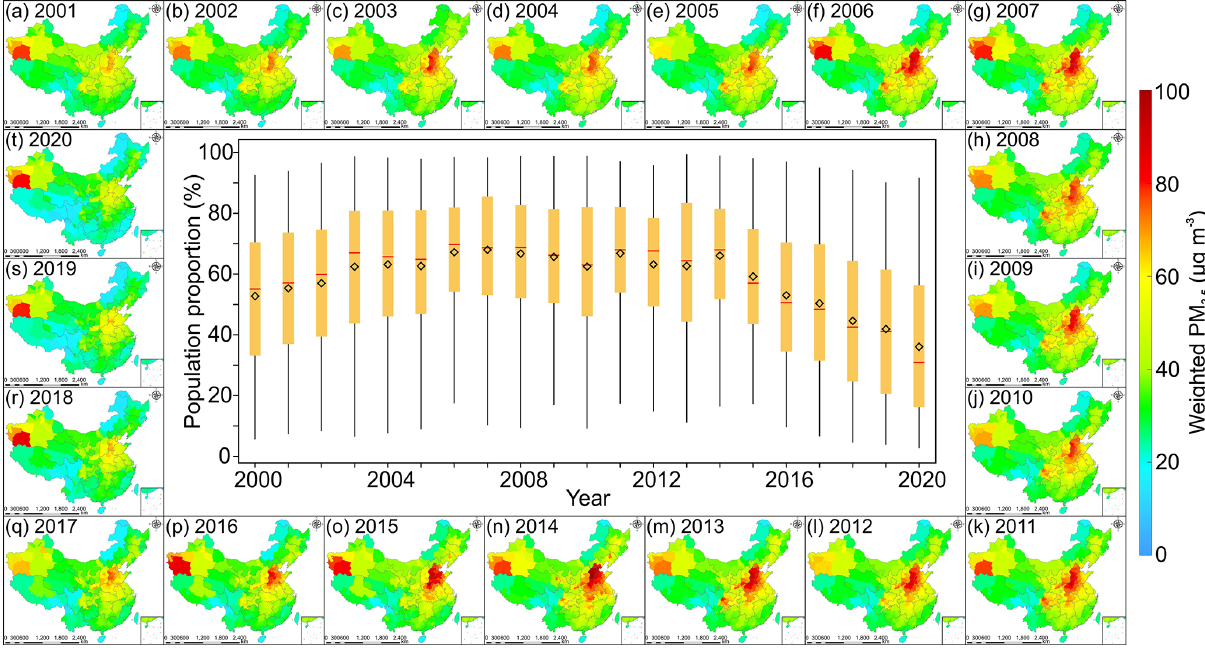
Figure 12. Spatial distribution of population-weighted PM 2 . 5 concentration and the proportion of the population exposed to PM 2 . 5 concen- tration greater than 35µgm − 3 . Annual and daily LGHAP PM 2 . 5 concentration data were used for the calculation of weighted PM 2 . 5 and the proportion of population exposure, respectively. The diamond and red line indicate the annual mean and median population proportion,